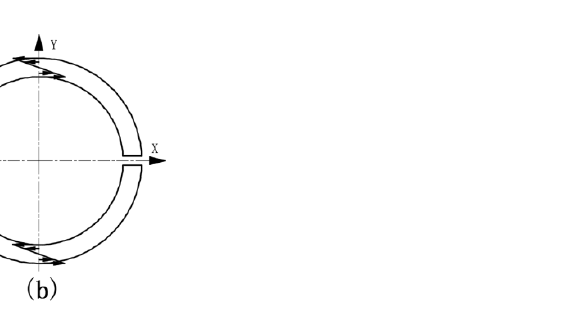
Figure 3. Shear stress distribution of thin-walled bars with a ( a ) closed and ( b ) open cross-section.